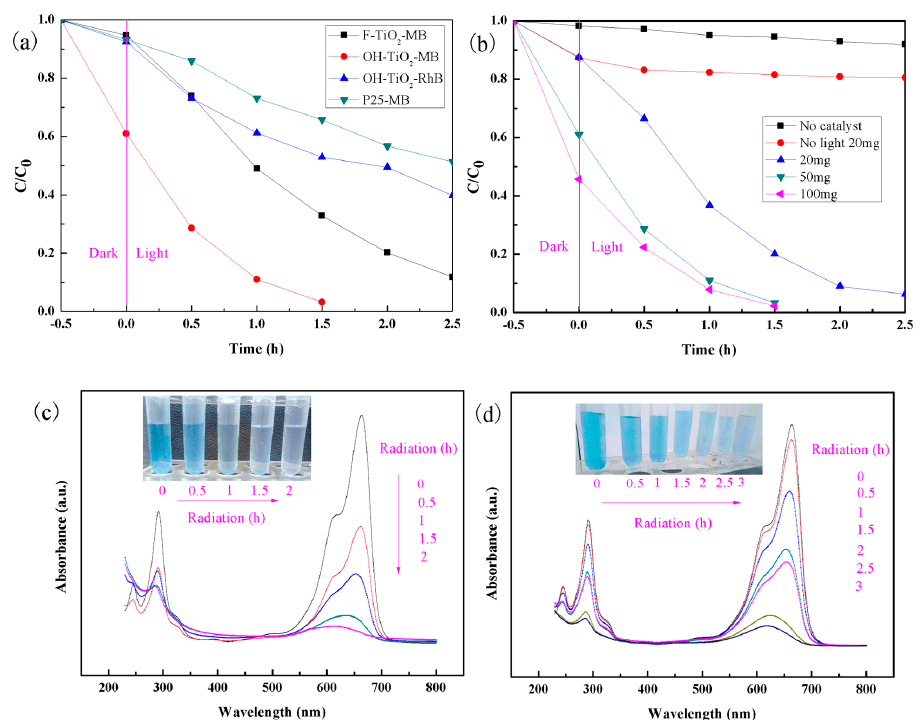
Figure 6. Photocatalytic performance of OH ‐ TiO 2 and F ‐ TiO 2 for MB and RhB and UV ‐ vis absorption